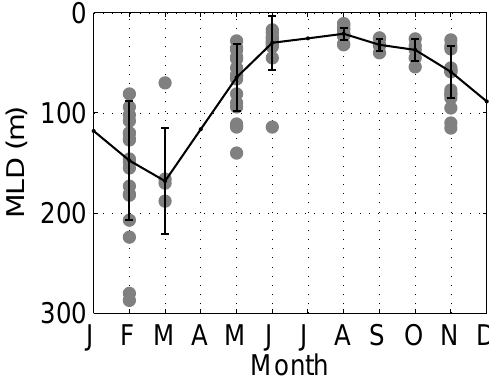
Figure 2. Calculated mixed layer depth (MLD) at the Iceland Sea time series station, using the density difference criteria of (cid:49)σ θ 0.05kgm − 3 . The grey dots show the MLD for each year, and the line is the median of the values for each month, and the error bars show the standard deviation (SD). The values for the months with- out shown data are